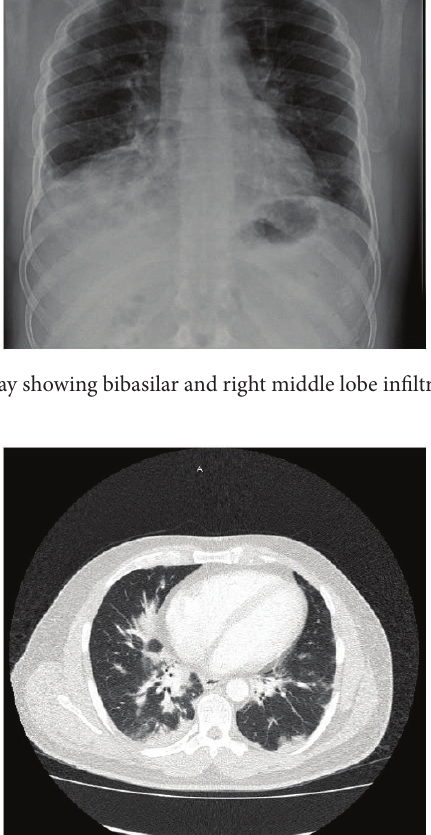
in both lungs along with traction bronchiectasis. No signif- icant pleural effusion, pneumothorax, or